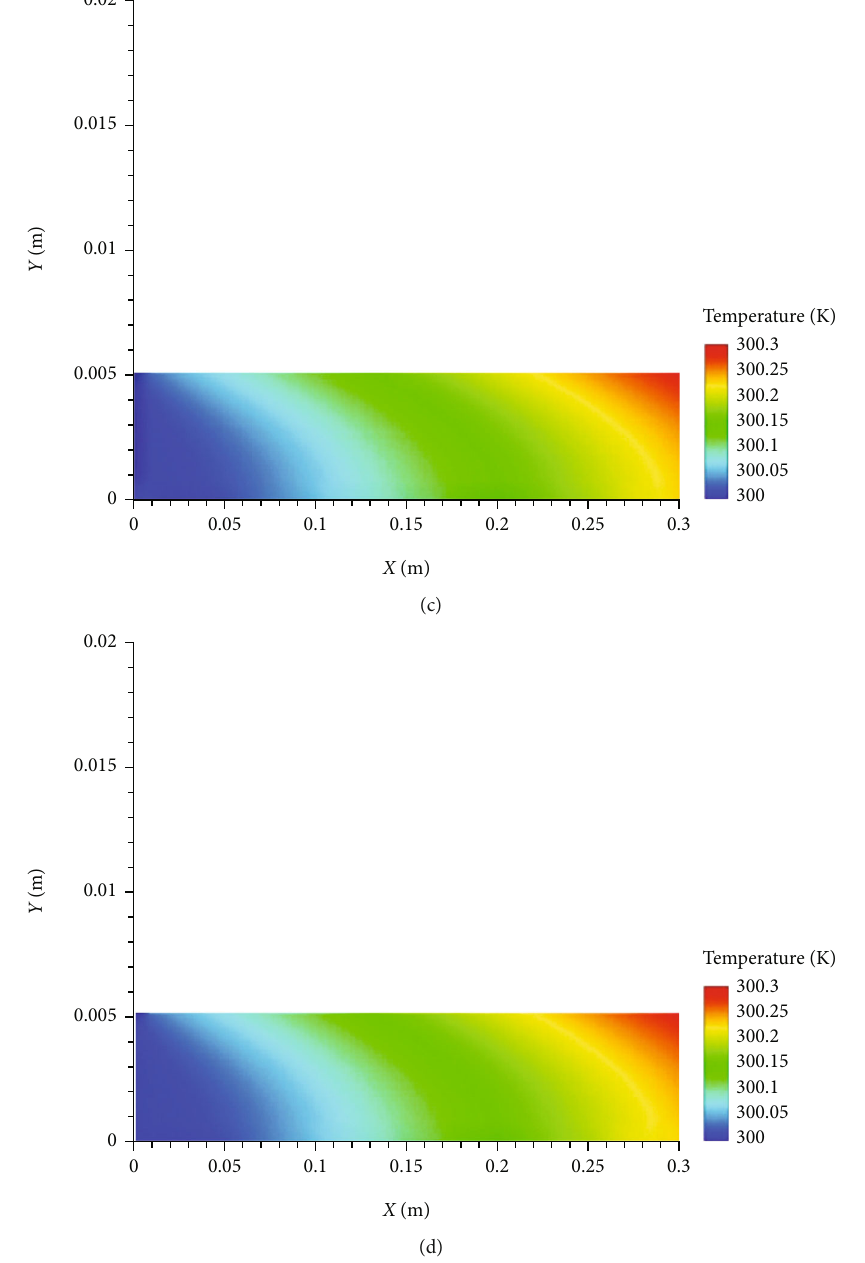
Figure 14: (a) Temperature contour for various slope angles for Al various slope angles for Al ( Da = 0 : 1, Ha = 40, ψ = 60 ° ). (d) Temperature contour for various slope angles for Al